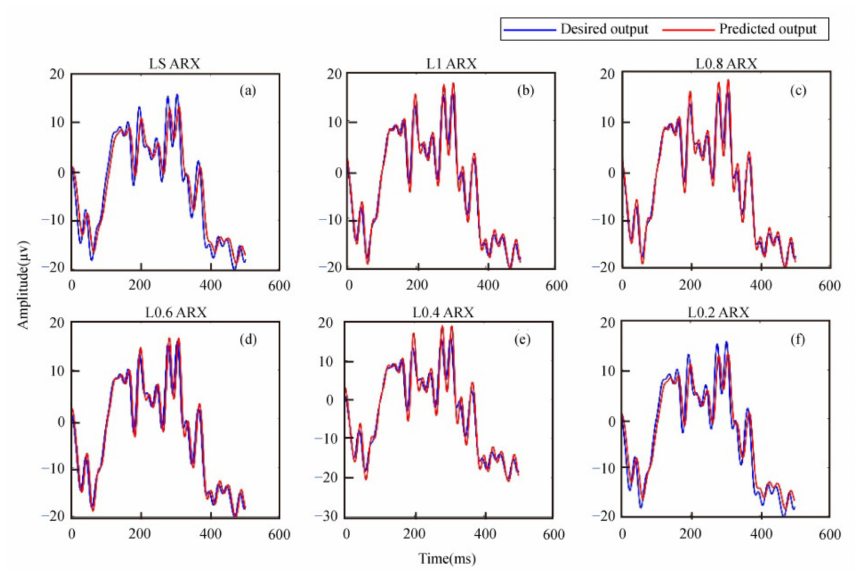
Figure 2. The waveforms of the desired output and the predicted results from six ARXs when outliers were mixed in the original data. ( a ) The predictive performance of the LS-ARX model. ( b – f ) The predictive performance of the Lp-ARX model ( p = 1, 0.8, 0.6, 0.4, 0.2).